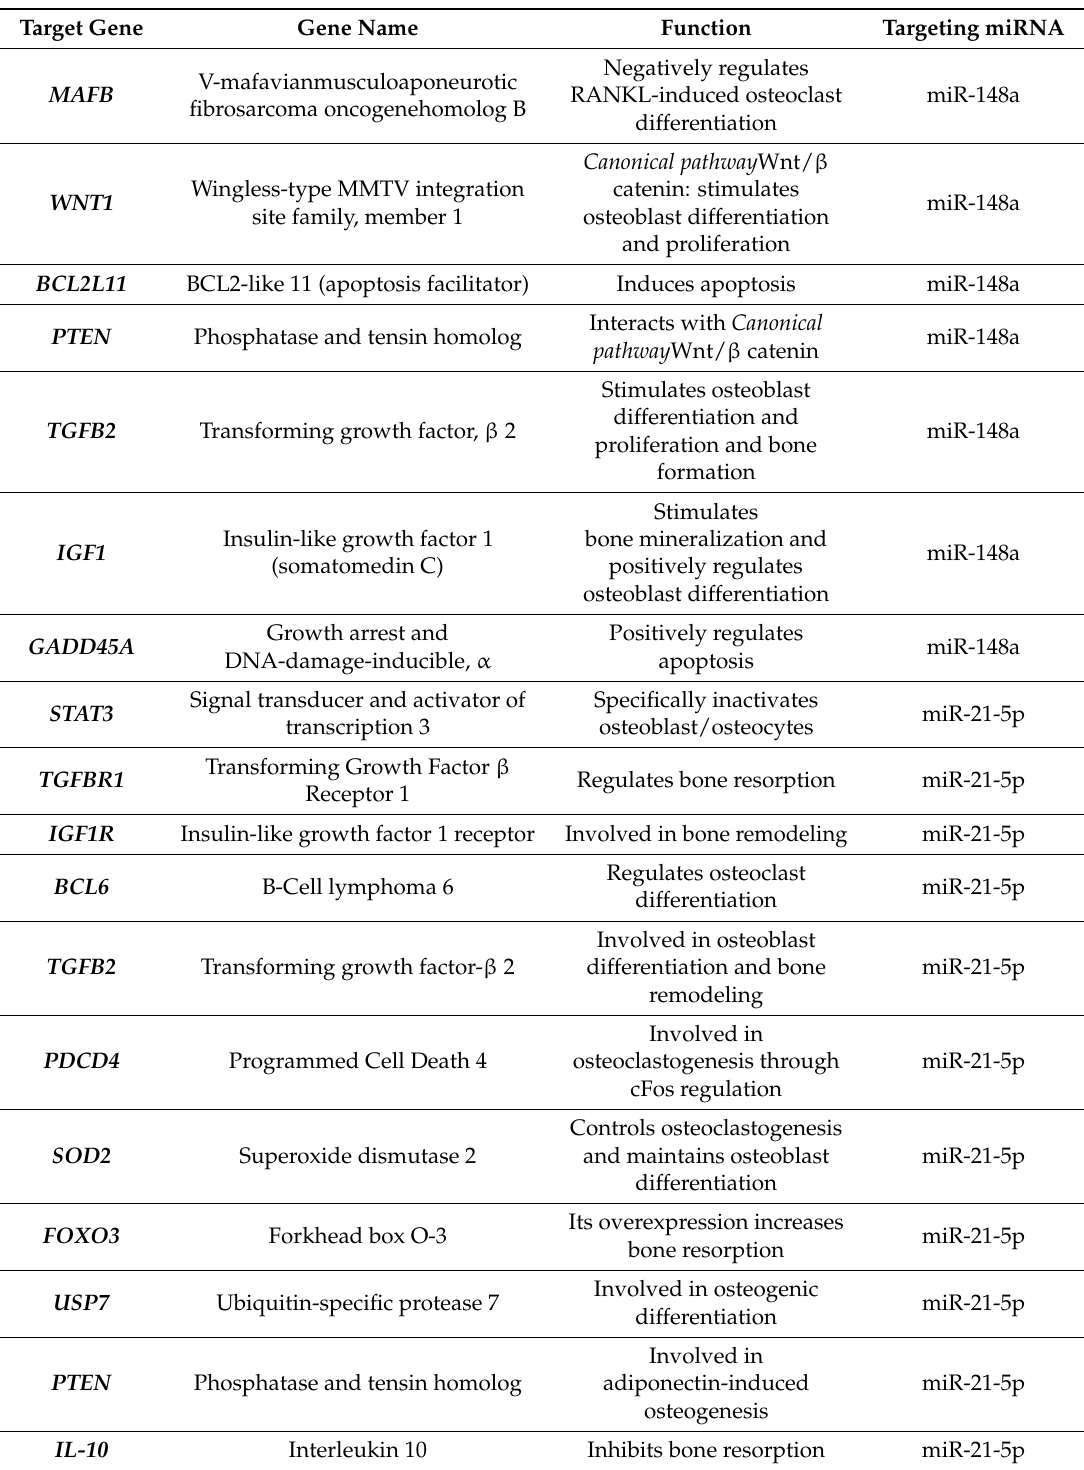
Table 3. Validated target genes of hsa-miR-148a and